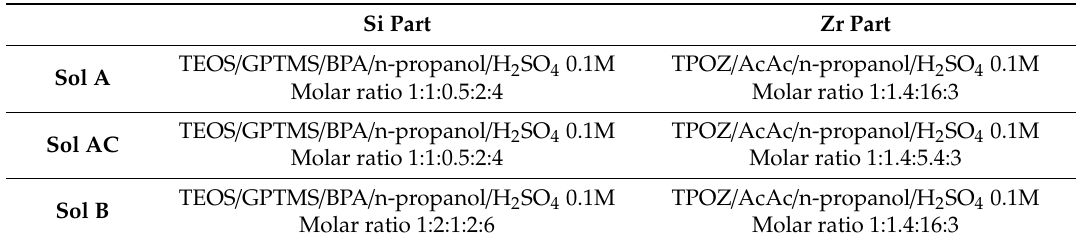
Table 2. Molar ratio of components used for preparing sols with and without organic precursors. Si Part